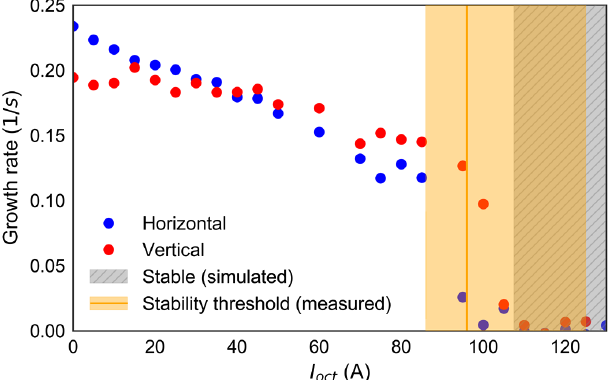
FIG. 6. P y HEADTAIL simulations showing the stabilization of a single bunch with Landau octupoles in the LHC at 6.5 TeV. Centroid growth rates vs Landau octupole current are shown, with the gray area indicating the cases that were stable over N 5 × 10 5 turns (compare Fig. t ¼